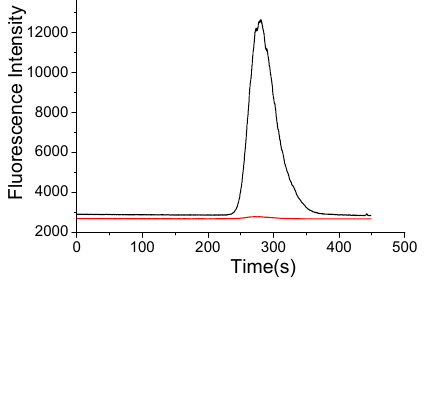
Figure 4. Electropherograms of the mixture of QDs, human IgG and DyLight labeled goat anti-human IgG with detection in two different channels (black: 612 nm for QDs; red: 670 nm for